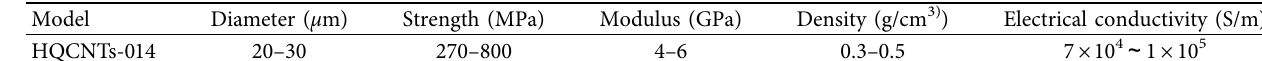
Figure 5: Relationship between strain and change rate of carbon nanotube yarns. Table 1: Main technical parameters of carbon nanotube yarns.